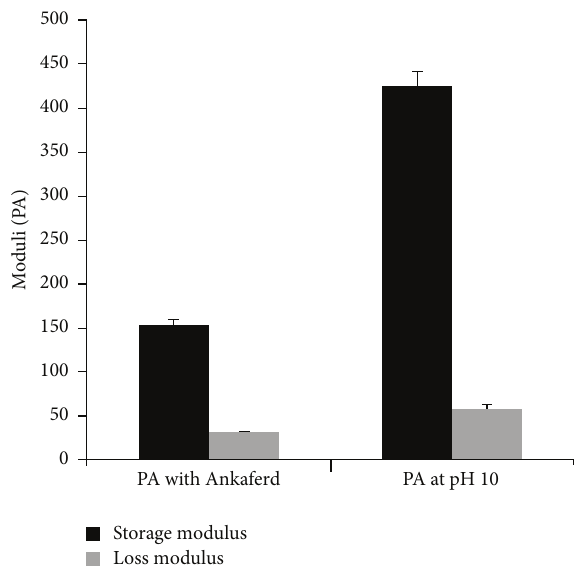
Figure 5: Comparison of mechanical character of PA-Ankaferd gel with PA gel formed at pH 10 by using oscillatory rheology.